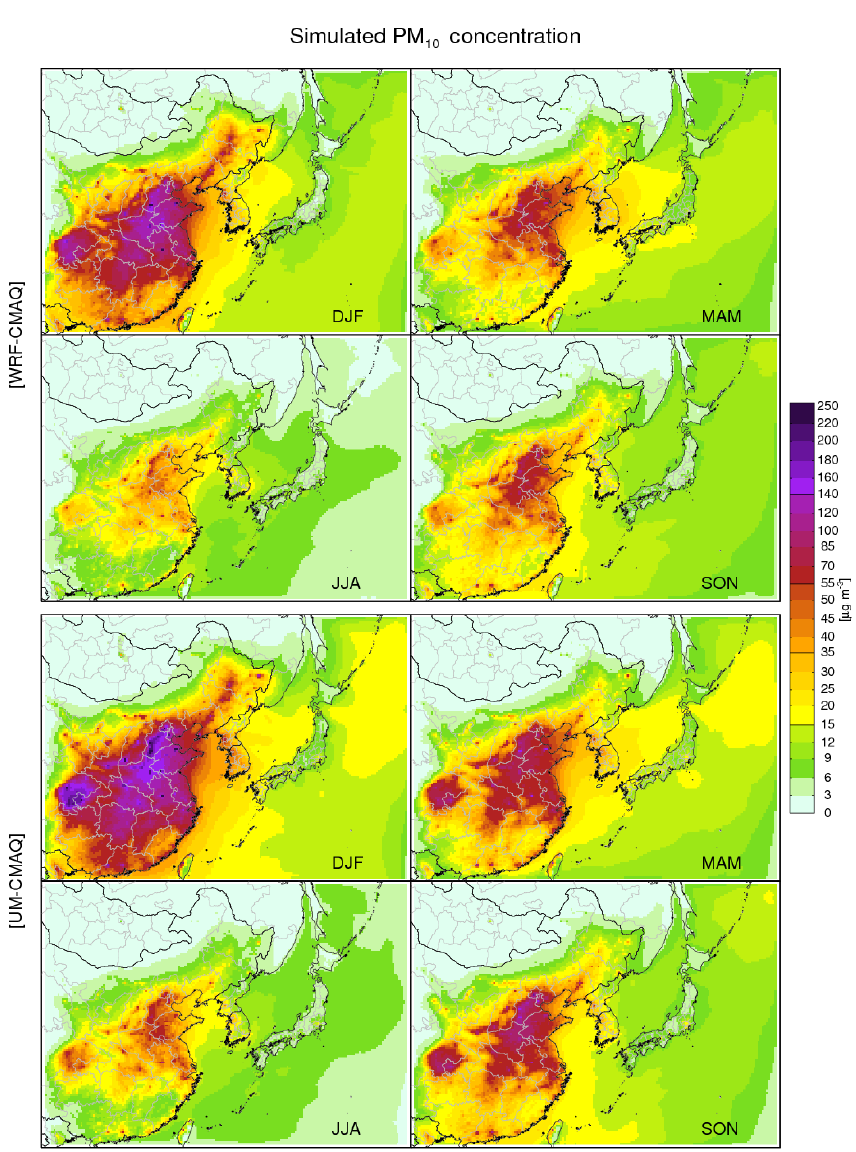
Figure 3. Spatial distributions of PM 10 concentrations over East Asia using the WRF-CMAQ and UM-CMAQ systems, as